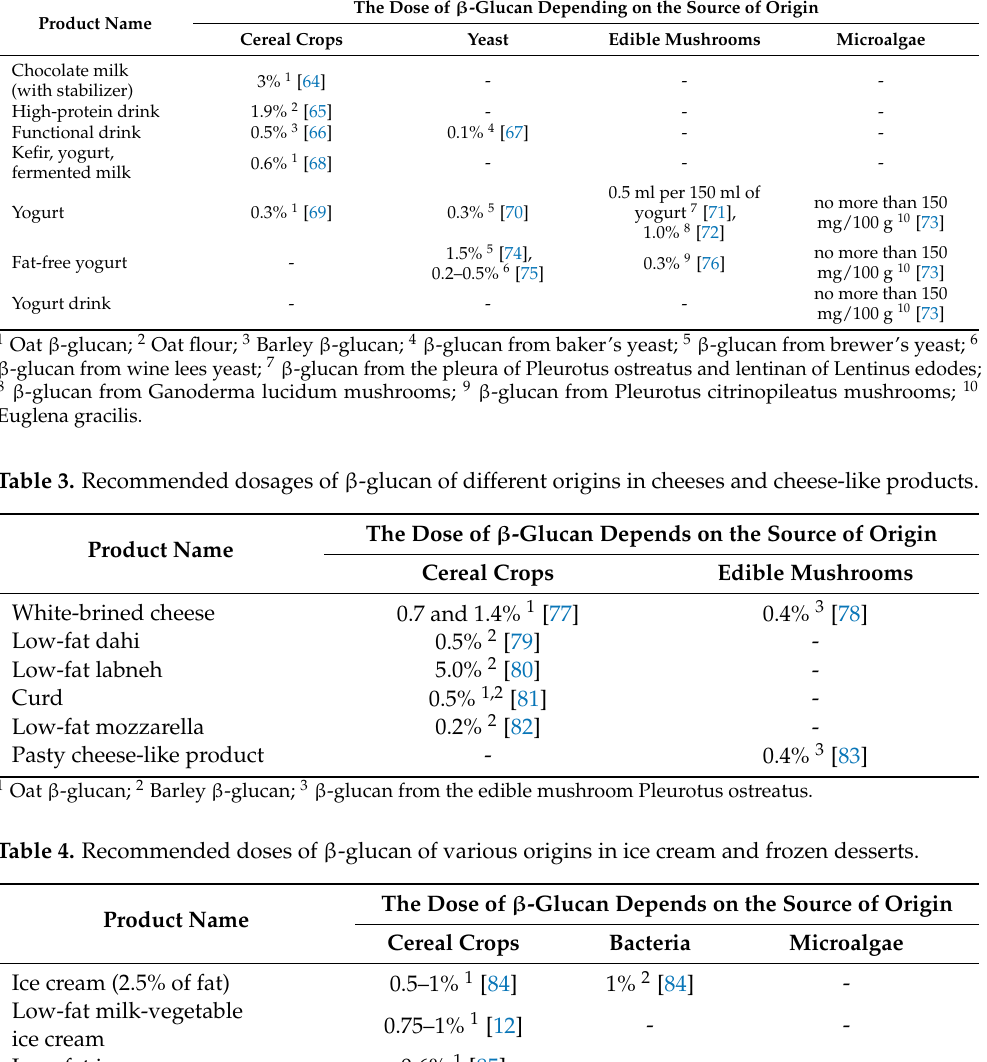
Table 2. Recommended doses of β -glucan of various origins in fermented and non-fermented drinks and fermented milk products.